Question: What does this figure show? Answer in one sentence.
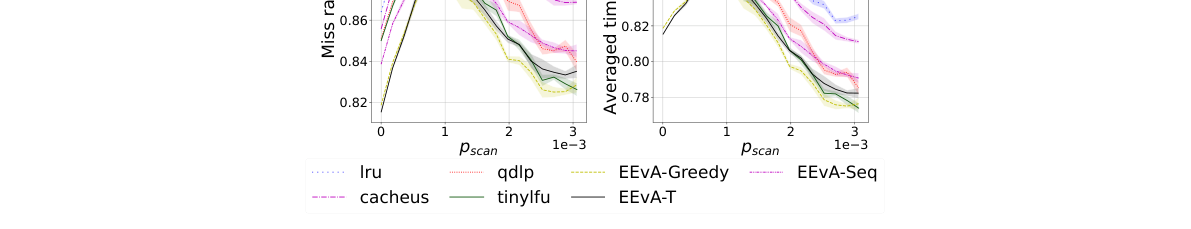
Answer: EEvA-based algorithms show the lowest miss rate and averaged time cost uniformly for the considered range of pscan values. The presented mean and variance values are computed over 5 runs.